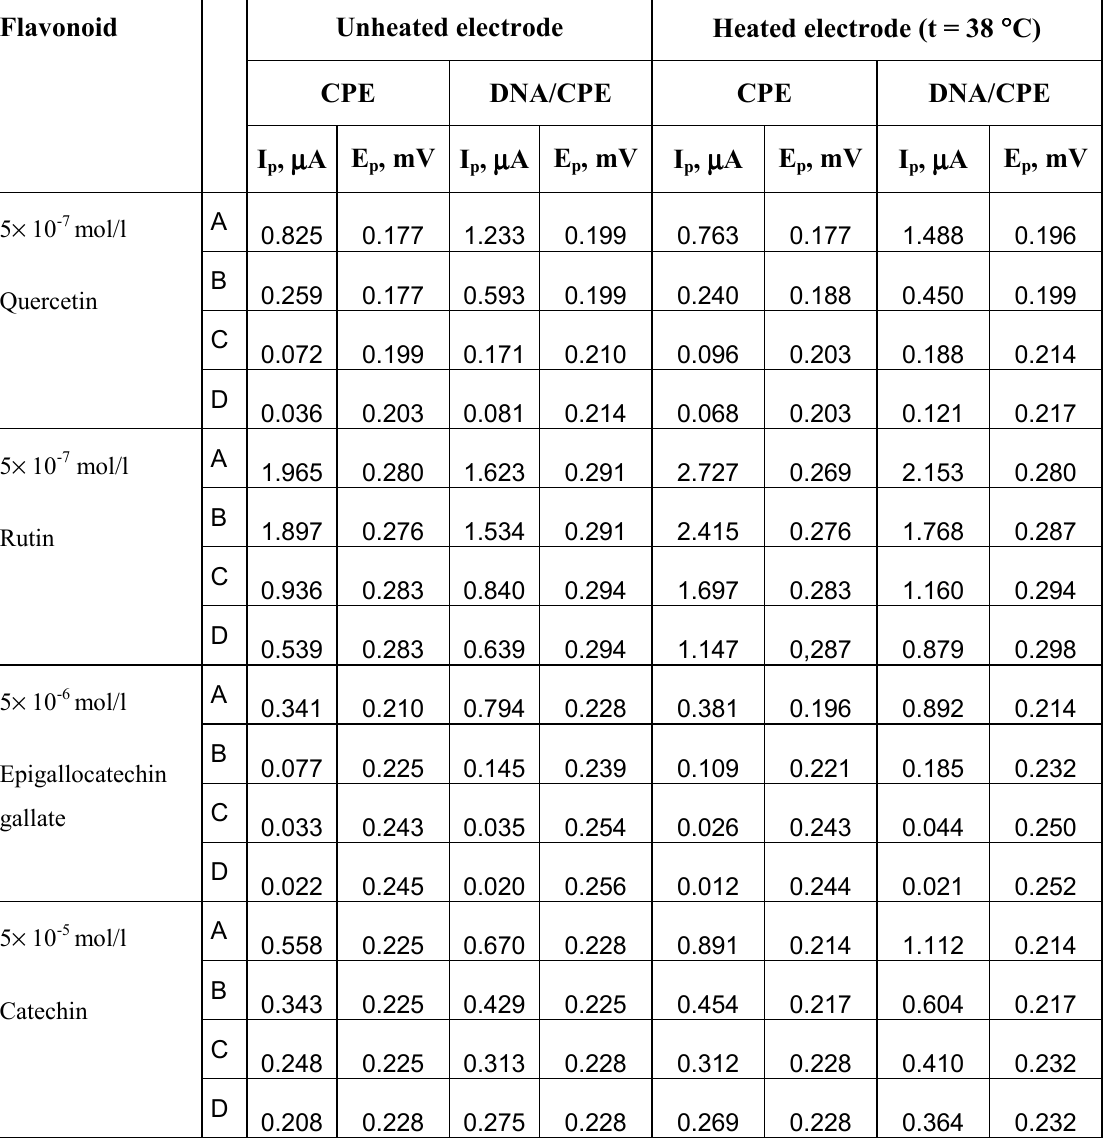
Table 1. Basic DPV characteristics of flavonoids measured at unheated and heated (38 ° C) CPE and DNA/CPE (A) after 120 s electrode treatment in solution of flavonoid in 5 mmol/l phosphate buffer pH 7.0 with 1 % DMSO, (B) medium exchange for the same blank electrolyte, (C) conditioning the electrode in blank 50 mmol/l phosphate buffer for 5 min and (D) conditioning the electrode in blank 50 mmol/l phosphate buffer for another 5